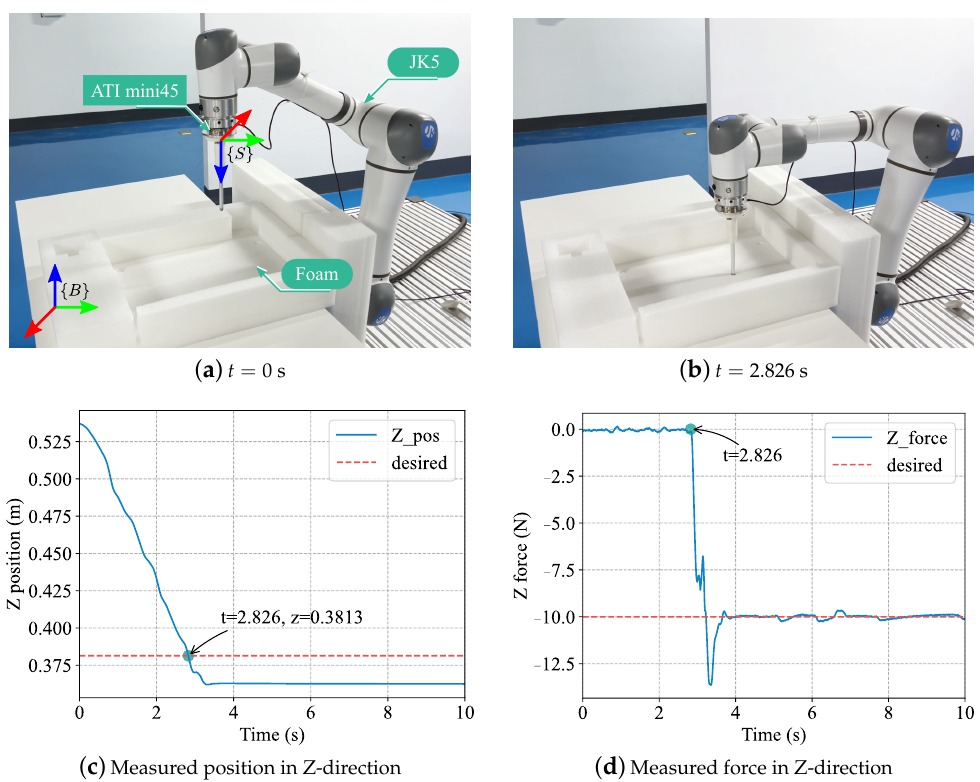
Figure 7. This figure shows the real-world experiment with the proposed NAIC method: ( a ) { B } denotes the robot base frame, and { S } is the force sensor frame; { S } can be obtained by rotating { B } with 180 ◦ around the y-axis; ( a , b ) demonstrate the motion of the robot. ( c , d ) are the measured Z-direction position and contact force,